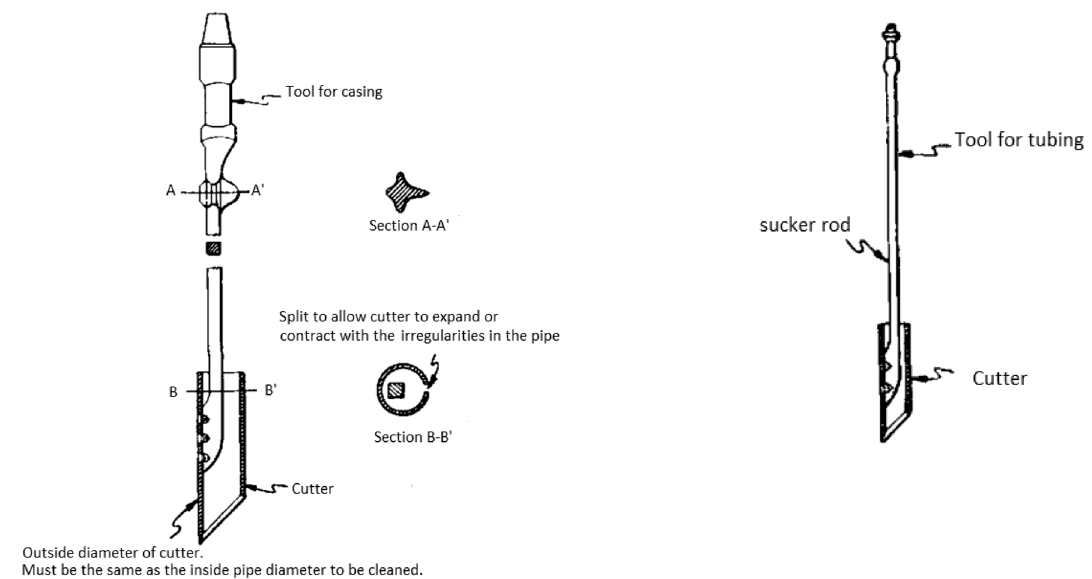
Fig. 6 Schematic representation of a wax cutting tool. Adapted from (Reistle and Blade 1932)